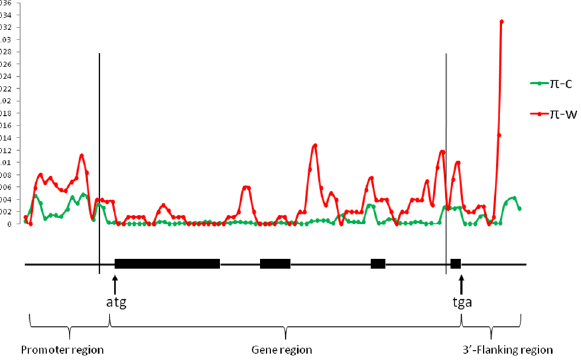
Fig 1. Sliding-window analysis of silent-site nucleotide diversity ( π value) for the entire Ma 3 region. Window length: 200; Step size: 100. Introns are indicated as thin lines, and exons are indicated as filled boxes. C: cultivated sorghum; W: wild